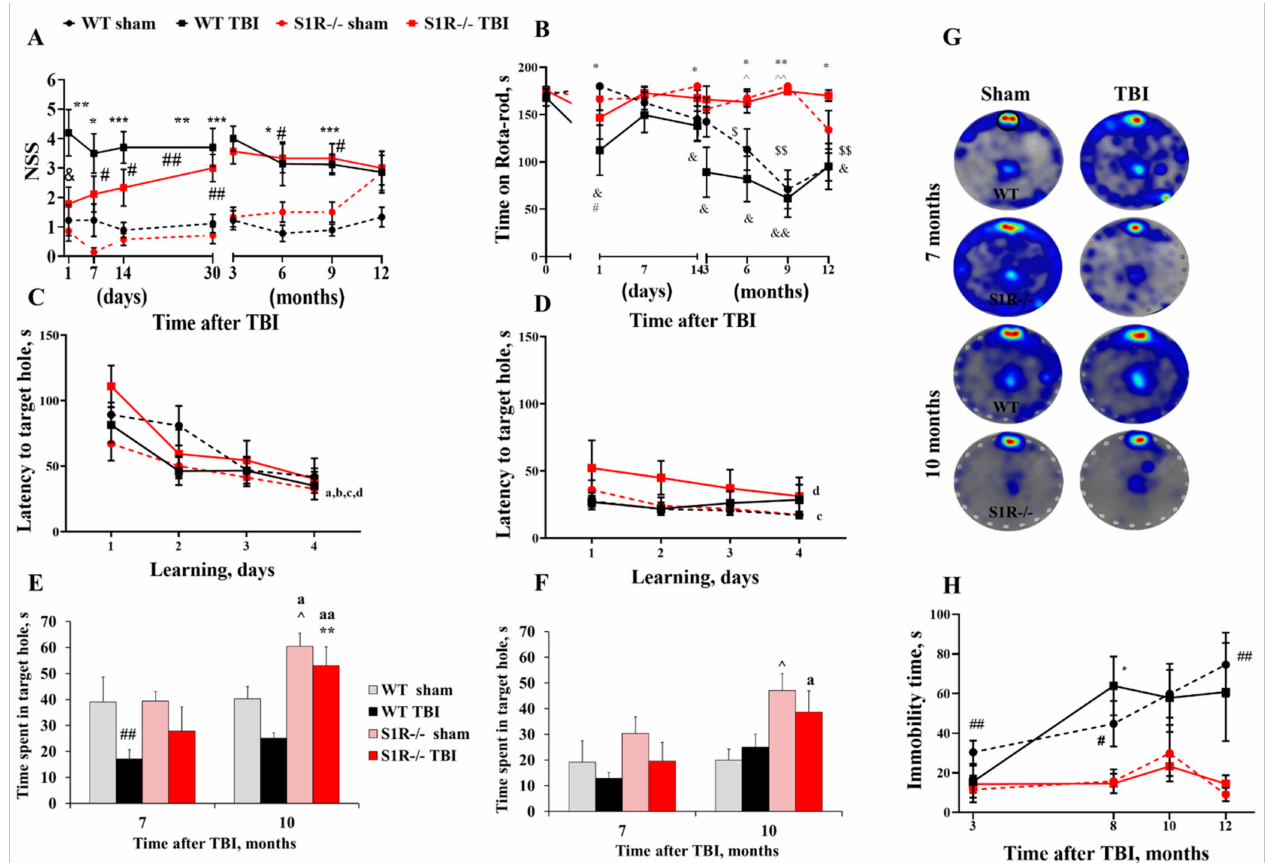
Figure 1. Long-term behavioral changes after traumatic brain injury (TBI). Behavioral testing revealed functional deficits in the ( A ) neurological severity score (NSS), ( B ) rota-rod (RR), ( C – G ) Barnes maze (BM), and ( H ) tail suspension tests. ( A ) Wild-type (WT) TBI mice showed neurological deficits compared to WT sham mice 24 h after injury. WT sham n = 9, WT TBI n = 7–10, Sigma-1 receptor knockout (S1R-/-) sham n = 6–8, S1R-/- TBI n = 6–9. * p < 0.05 WT TBI vs. S1R-/- TBI, # p < 0.05, ## p < 0.01 sham vs. TBI (the black symbols represent differences between WT groups, and the red symbols represent differences between S1R-/- groups). ( B ) WT TBI mice spent less time on the RR than WT sham mice 24 h after injury. Motor coordination was impaired in the WT TBI group at all time points after injury compared to baseline values. Motor coordination remained unaffected in S1R-/- mice after TBI. WT sham n = 8, WT TBI n = 6–9, S1R-/- sham n = 7, S1R-/- TBI n = 6–9. * p < 0.05, ** p < 0.01, *** p < 0.001 WT TBI vs. S1R-/- TBI, ˆ p < 0.05, ˆˆ p < 0.01 WT sham vs. S1R-/-